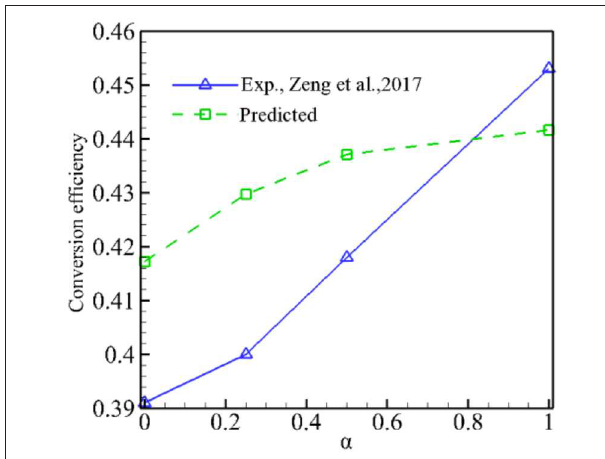
FIGURE 7 | Predicted conversion efficiency as a function of α for φ